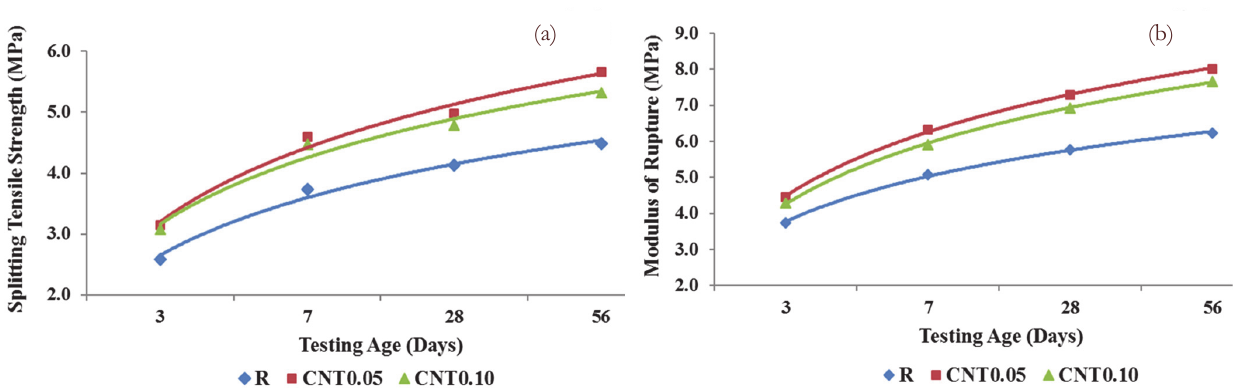
Figure 2: (a) Splitting cylinder tensile strength of concrete mixes; (b) Modulus of rupture of concrete